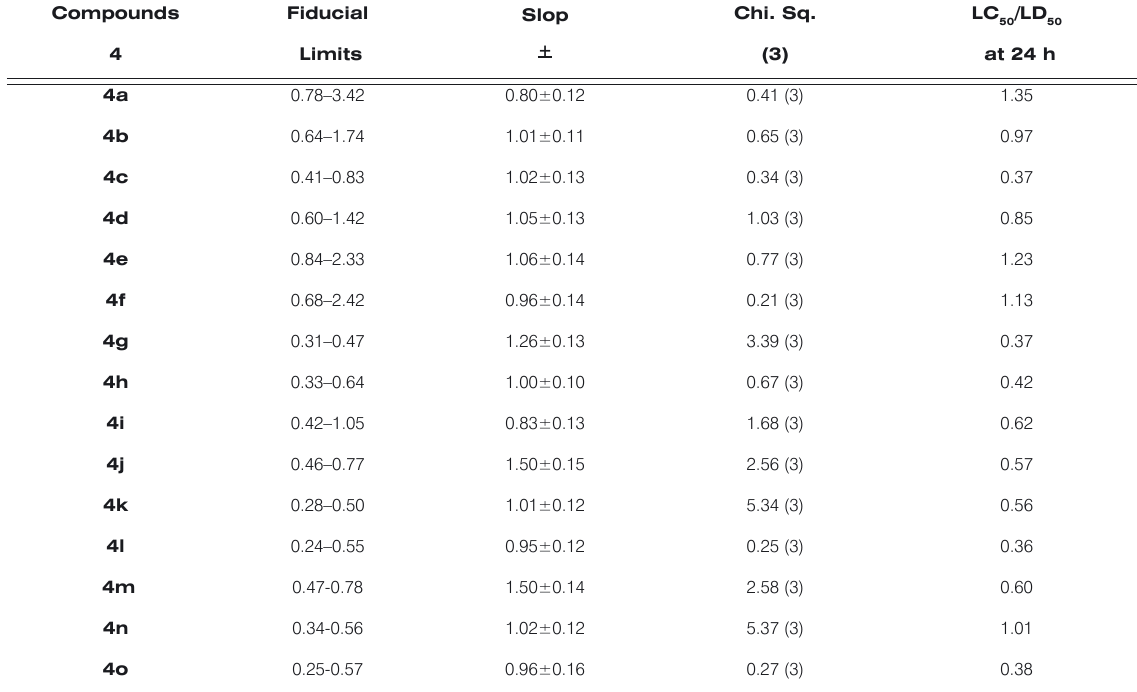
Table 4. Antifeedant activity of compounds 4a - 4o